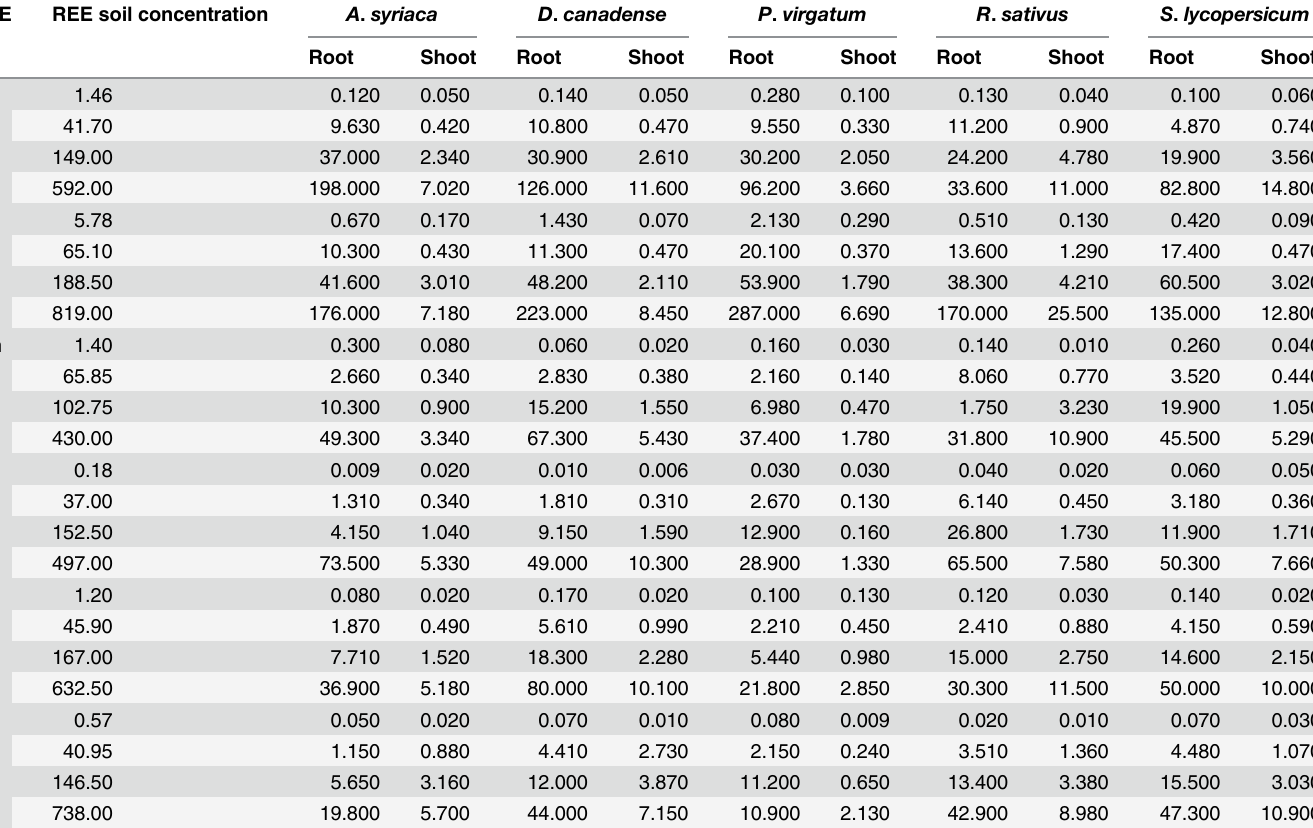
Table 6. Rare earth elements (REE) soil concentration (mg REE/kg dry soil) and measured concentrations (mg REE/kg dry biomass) in the roots and shoots (aboveground biomass) of the five plant species grown in REE contaminated artificial